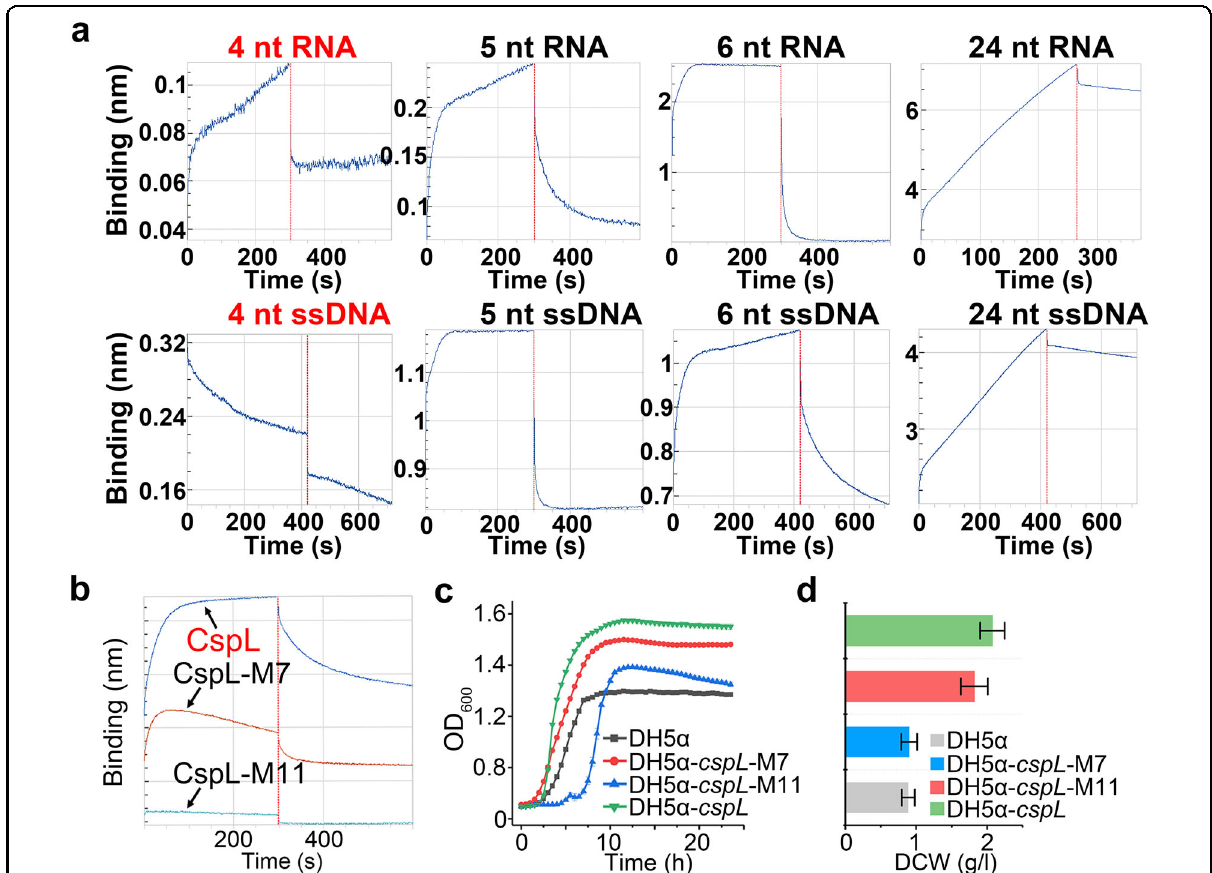
Fig. 3 Validation of the function of CspL in vitro. a Binding of variously-sized RNA and ssDNA fragments to CspL. The vertical red line separates the association and disassociation steps. An absolute binding value <0.05 nm indicates no binding signal. b Bio Layer Interferometer (BLI) for testing seven conserved amino acid-mutations. c , d The growth curves ( c ) and DCWs ( d ) of mutants compared with the WT and the empty vector control. ** P < 0.01 and *** P < 0.001 (two-tailed Student ’ s t